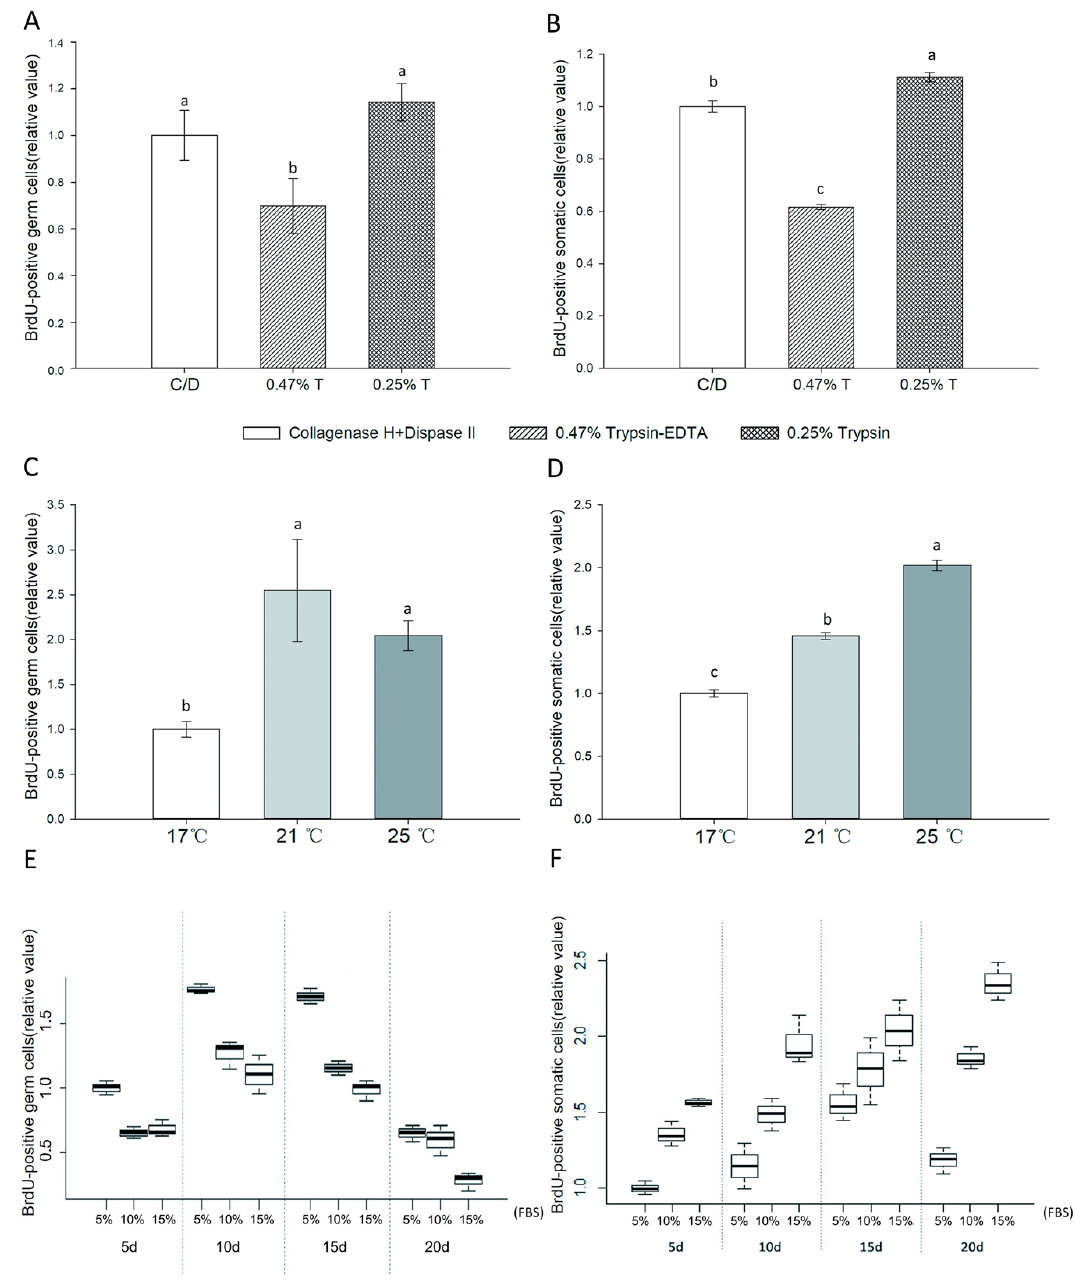
Figure 3. Influence of enzymatic dissociation ( A , B ), culture temperature ( C , D ), and FBS (5–15%) ( E , F ) on BrdU incorporation into Dabry’s sturgeon germ cells. ( A , B ): Gonads were dissociated with 2 mg/mL collagenase H and 500 U/mL Dispase II (C/D); 0.25% trypsin (0.25% T), or 0.47% trypsin– Ethylenediaminetetraacetic acid (EDTA, 0.47% T-EDTA). Cells were cultured in L-15 medium (pH 8.0) supplemented with 15% FBS for 10 d at 25 ◦ C. ( C , D ) Gonad was dissociated with 0.25% trypsin and cultured in L-15 medium supplemented with 15% FBS (pH 8.0) for 10 d at 17, 21, and 25 ◦ C. ( E , F ) Gonad was dissociated with 0.25% trypsin and cultured in L-15 medium (pH 8.0) under selected concentrations of FBS (5–15%) at 21 ◦ C. BrdU assays were performed every 5 d. Data are shown as mean ± SEM ( n = 4) of relative values for germ cells and somatic cells by immunofluorescent co-localization of BrdU and Vasa. The values of collagenase H, Dispase II ( A , B ), 17 ◦ C ( C , D ), and 5% FBS (5 d) ( E , F ) were defined as the relative value 1.0. Values with different lowercase letters are significantly different ( p <